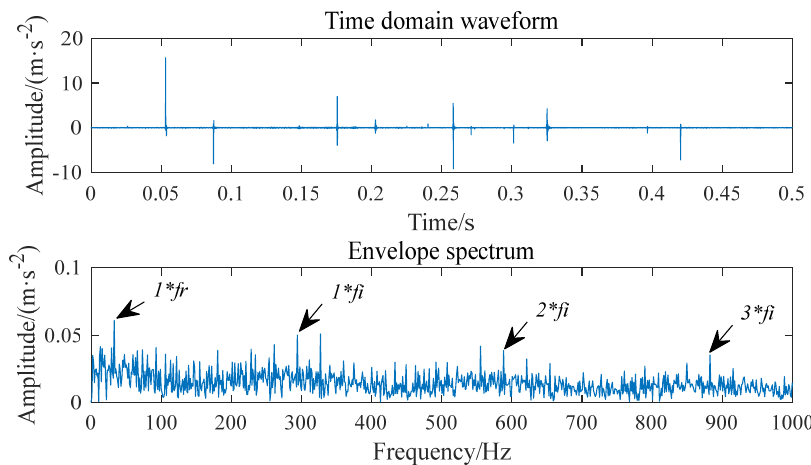
Figure 21. Reconstructed signal and its envelope spectrum obtained by BPDN algorithm based on the Symlet8 wavelet packet.